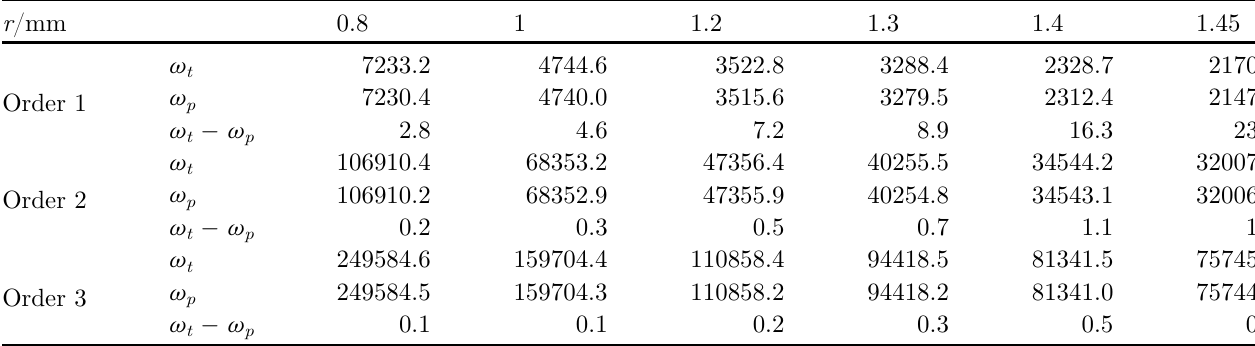
Table 10. Changes of natural frequency with r with and without damping (rad/s).